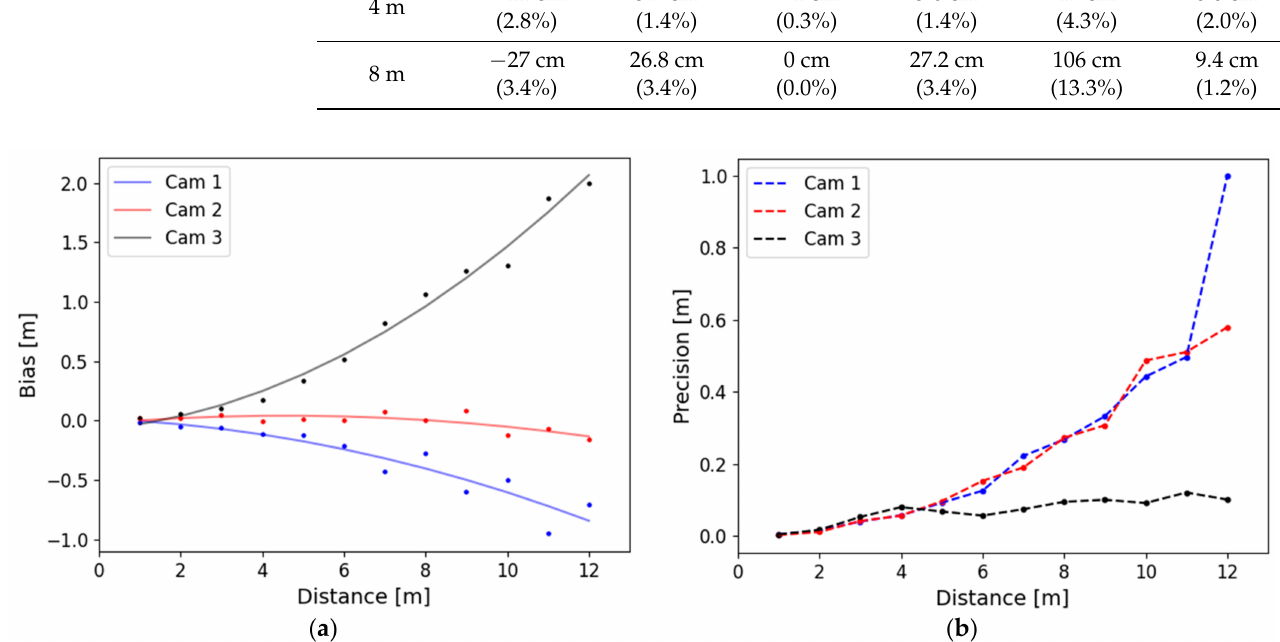
Figure 12. Performance evaluation of depth measurements by three different D455 units (cam 1–3): ( a ) bias in relation to measuring distance; ( b ) precision in relation to measuring